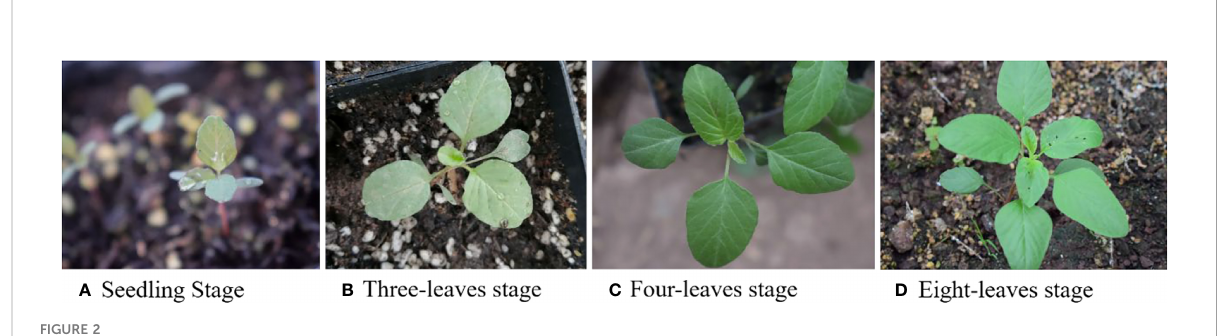
FIGURE 2 Morphological appearance of purslane at different growth